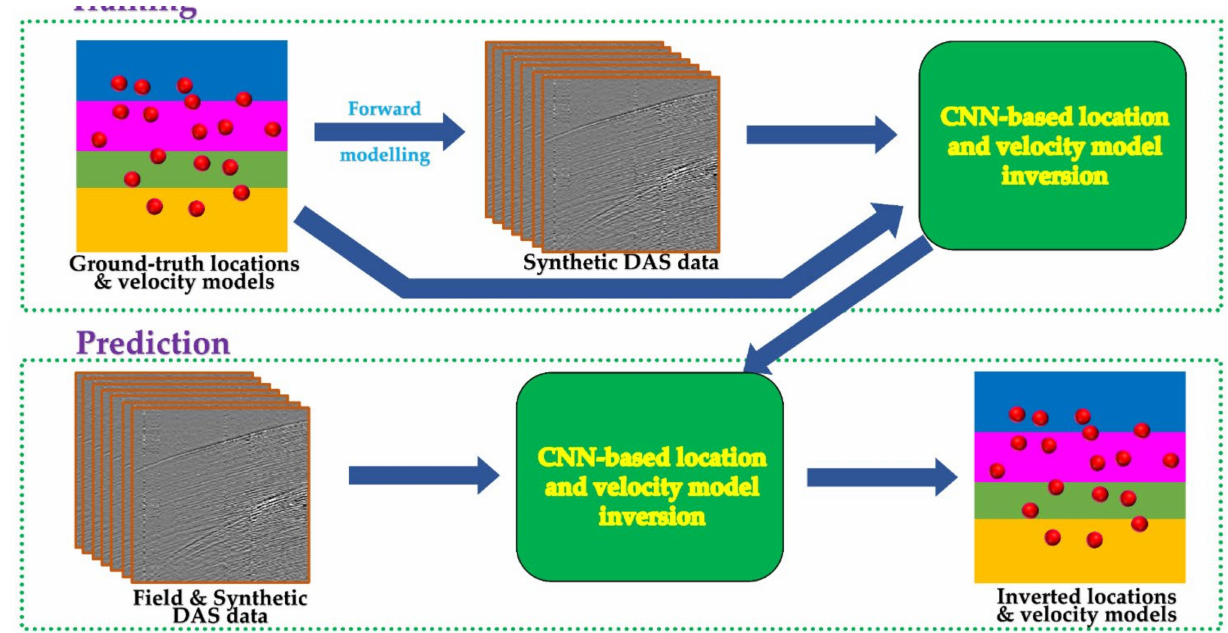
Figure 5. Flow chart depicting CNN-based microseismic events location and velocity model update network. The main processes of forward modeling, training and prediction are highlighted and linked with the arrows. Red dots represent microseismic